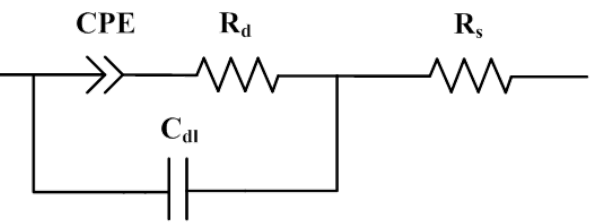
Figure 5. Equivalent electric circuit for a frequency range of 10 −1 to 10 7